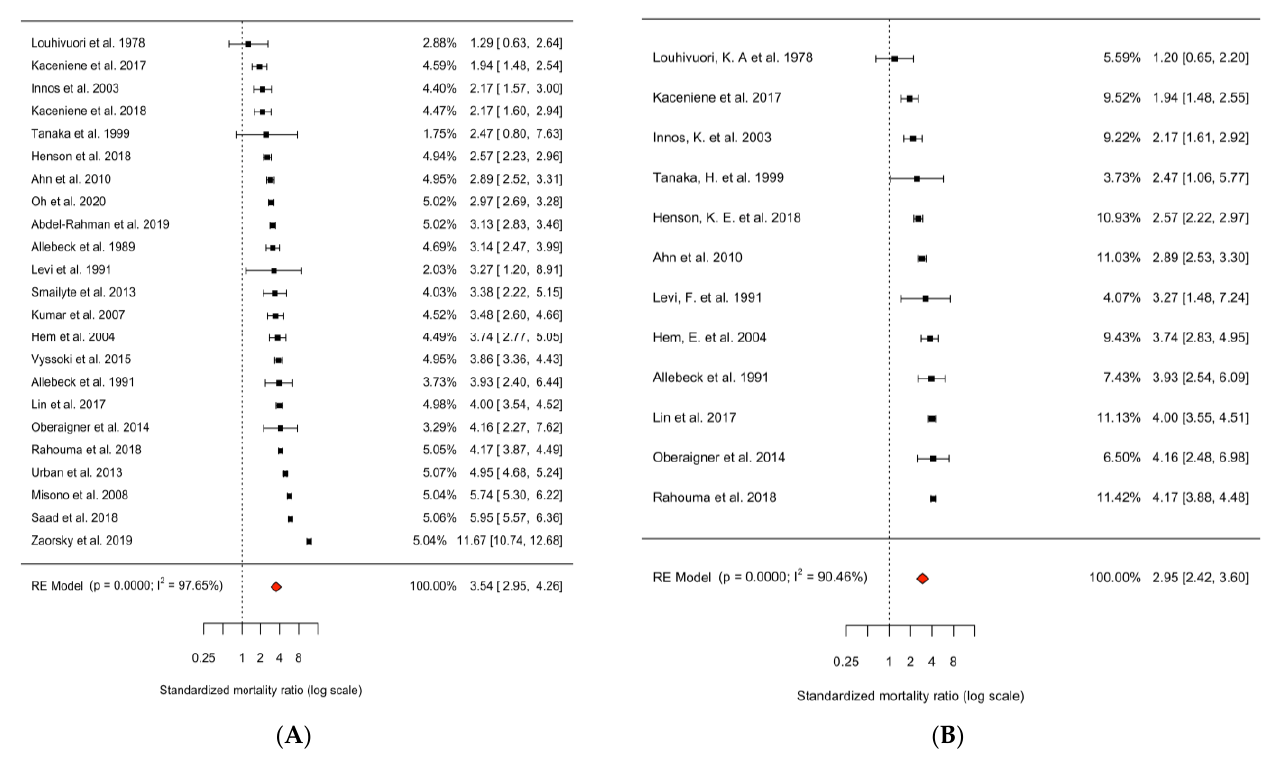
Figure 2. Forest plot of random effects meta-analysis of cohort studies of suicide in patients with lung cancer compared to the general population. ( A ) All 23 cohort studies (of suicide in lung cancer patients), I 2 = 97.76%, P-heterogeneity < 0.0001. ( B ) 12 non-overlapping cohort studies (of suicide in lung cancer patients), I 2 = 90.46%, P-heterogeneity < 0.0001. All studies were sorted by risk estimate ized mortality ratio; CI, confidence interval [6 – 12,16,30 – 44].